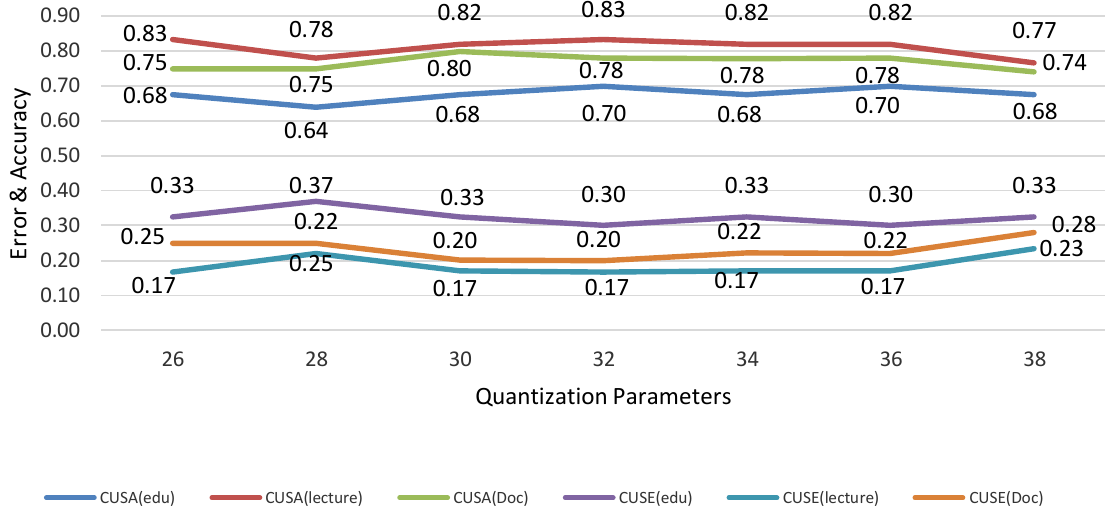
Figure 10. CUS A and CUS E variation based on QP